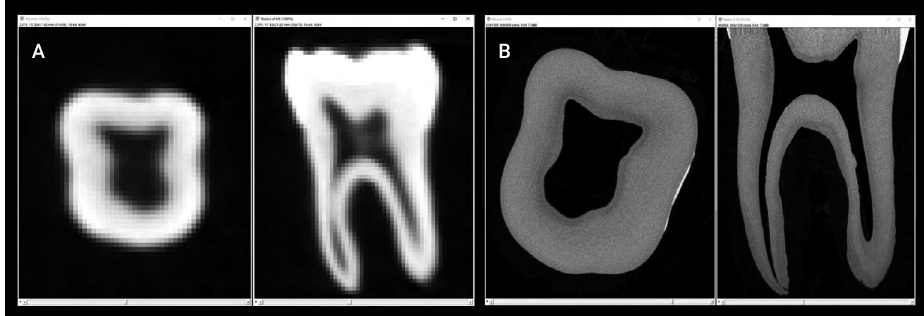
Figure 1. Image stacks visualized using ImageJ/Fiji software. Cone beam computed tomography (A); micro-computed tomography (B).